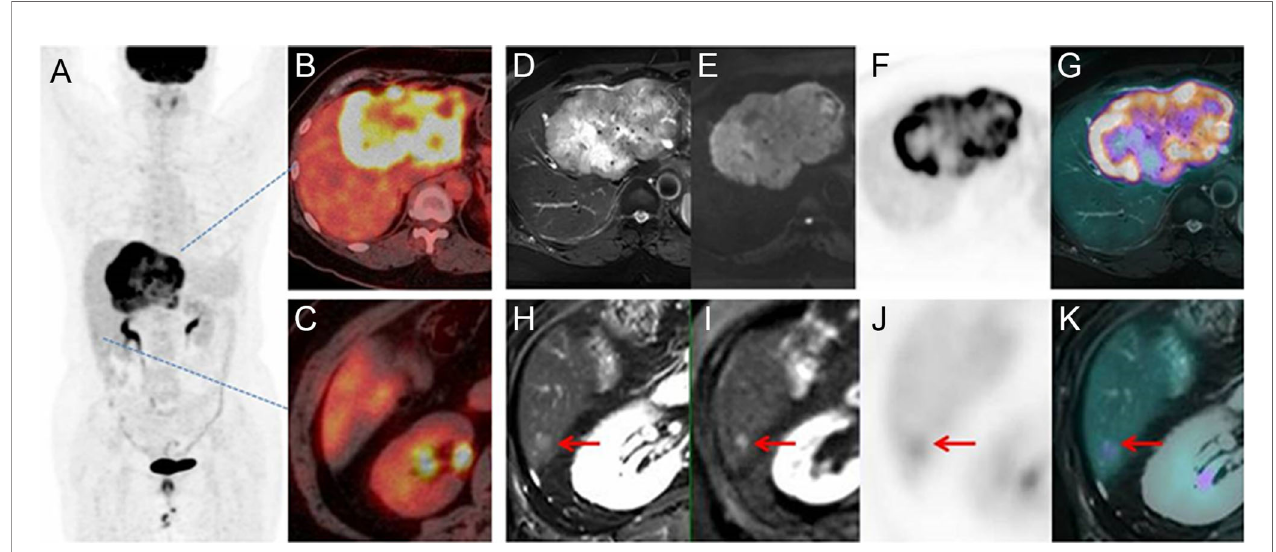
FIGURE 5 | Images of a 63-year-old patient with liver mass. PET/CT MIP (A) and fusion image (B, C) showed a mass with high FDG uptake and no metastasis on the liver or distant organ. On PET/MR, the mass had hyperintensity on T2WI and DWI, with high FDG uptake on PET and fused image (D – G) . A 6-mm lesion was an additional fi nding by PET/MR (H – K) . Therefore, the stage was upgraded from M0 to